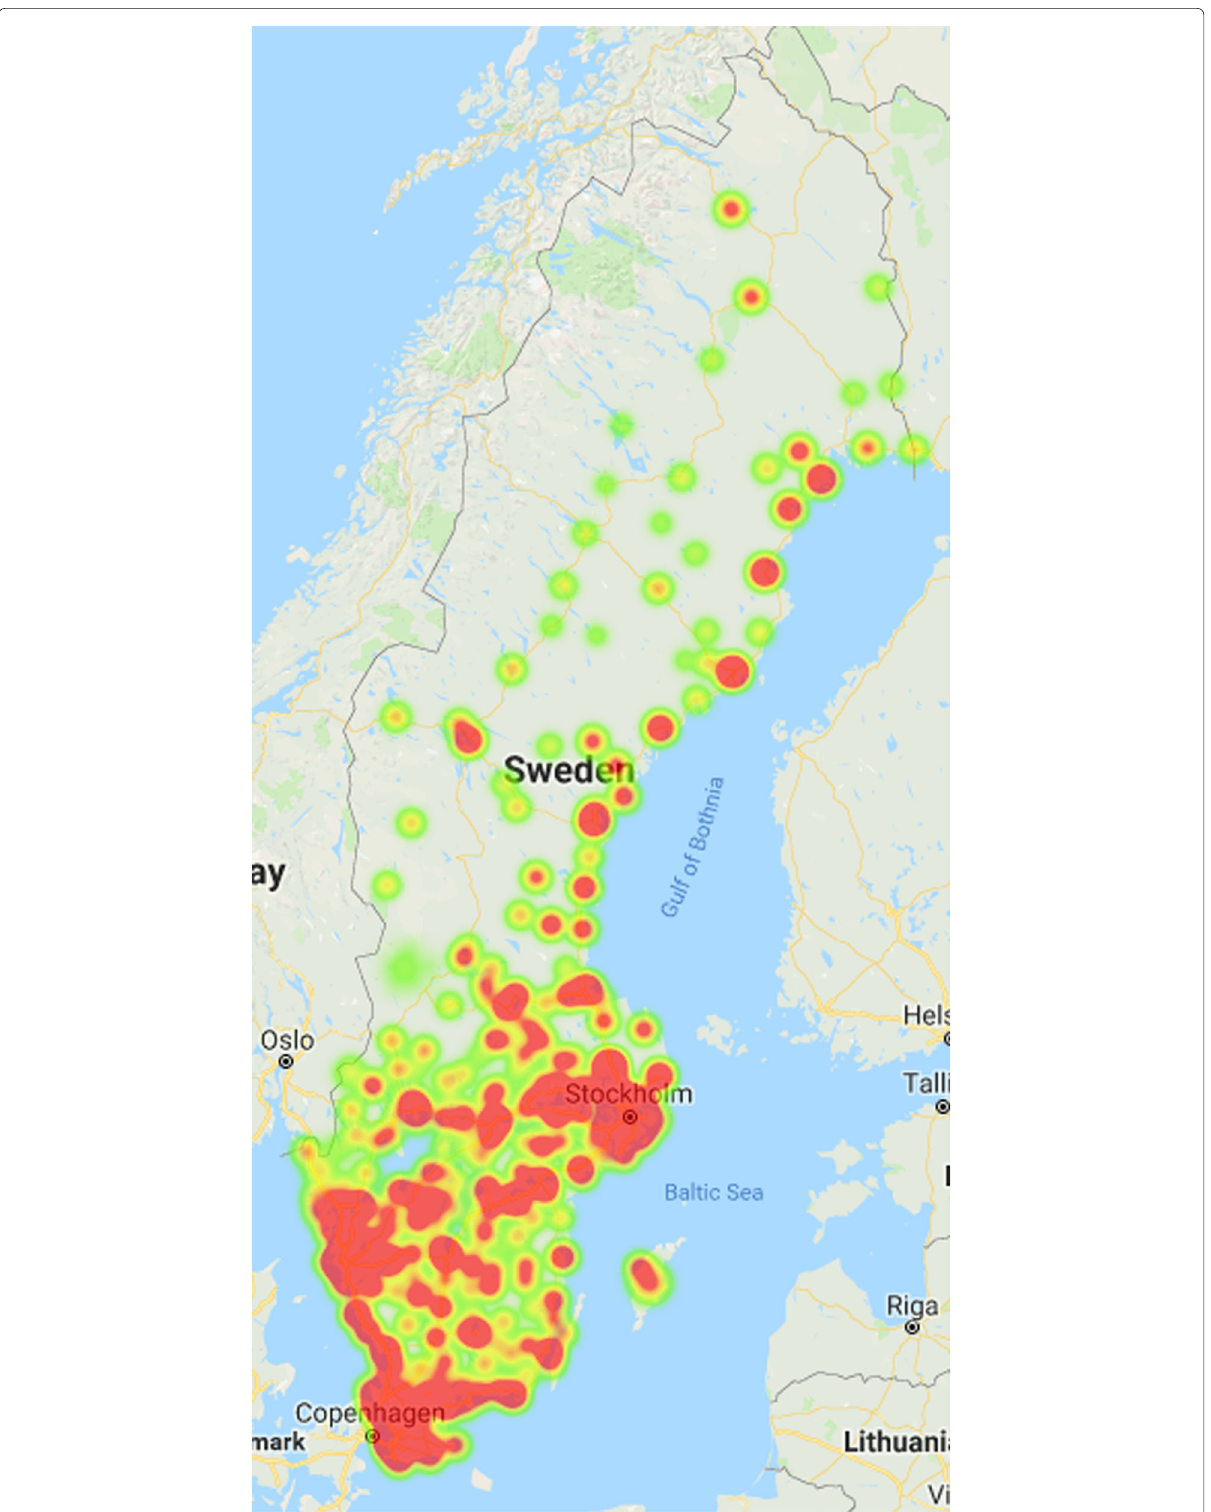
Fig. 6 Heap map showing enrollment locations of 200,000